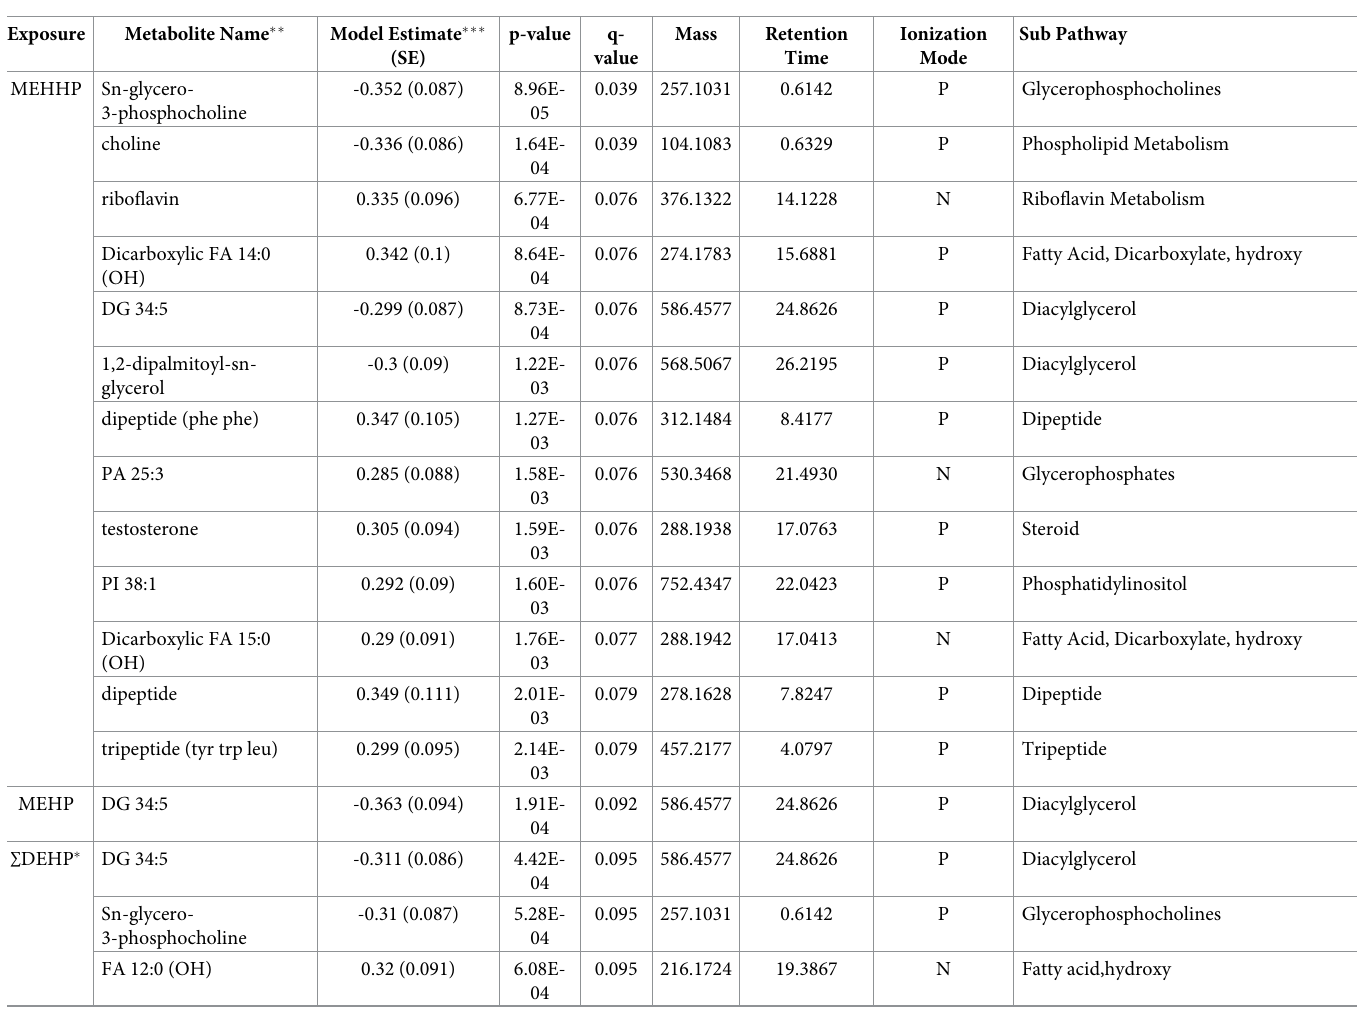
Figs 1, 2, S1 and S2 Figs display these clusters; we refer to them hereafter by their labels within the figures. There were 2 clusters of highly correlated metabolites associated with T3 MCPP exposure: 1) a FA metabolism cluster (acylcarnitines and other carnitines, decenoic acids and other 10 to 16 carbon FAs) that was positively associated with T3 MCPP (Cluster 1 in Fig 1) and 2) diacylglycerols (DGs) that were inversely associated with T3 MCPP. Correlation analy- sis of metabolites associated with the DEHP biomarkers MECPP (Fig 2) or MEHHP (S1 Fig) among girls were similar, showing 3 clusters. The largest cluster (Cluster 2 in the figures) included testosterone, riboflavin, dicarboxylic FAs, phosphatidylinositols (PIs) and phospha- tidic acids (PAs) that were correlated with one another and positively associated with MECPP and/or MEHPP. The next cluster contained acylcarnitines and medium to long-chain